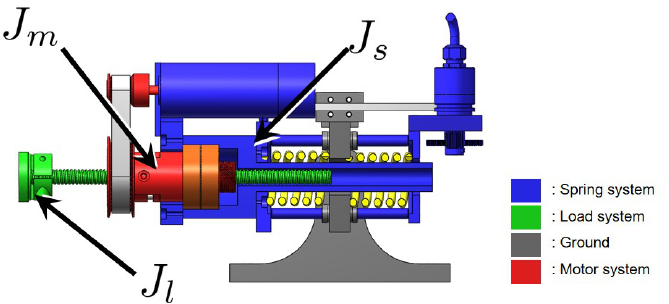
Figure 11. The inertia J m , J l and J s of RFSEA [24].